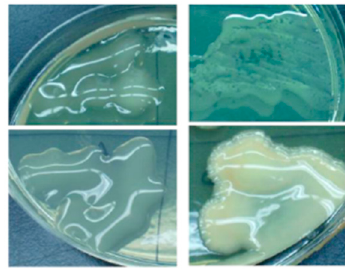
Figure 1. EPS production on an agar plate with the slimy appearance of the strains able to produce EPSs.